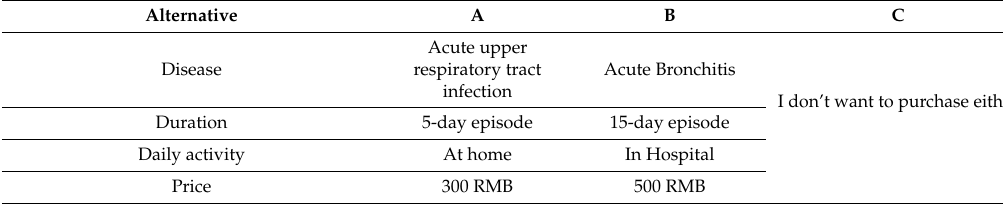
Table A4. Choice set 4.